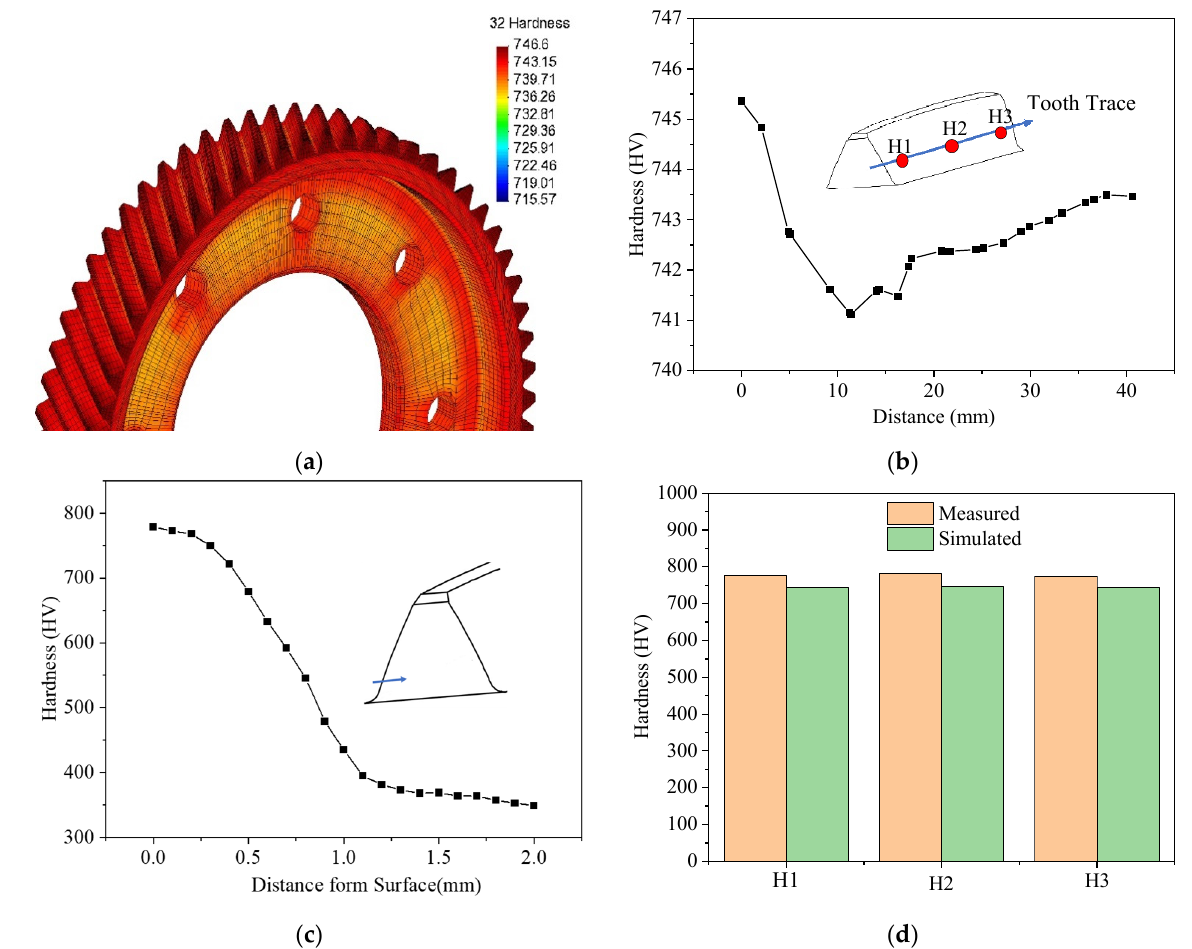
Figure 9. ( a ) Hardness distribution cloud atlas after carburizing and quenching; ( b ) simulation value of surface hardness; ( c ) measured in-depth micro-hardness of the carburized specimens; and ( d ) measured and simulated surface hardness value contrast.